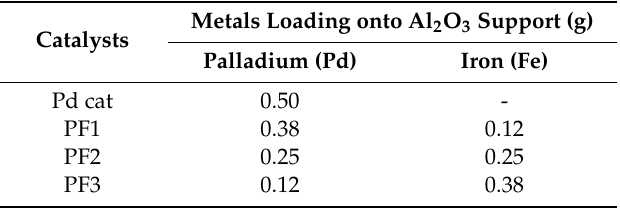
Table 5. The amount of metals loading on Al 2 O 3